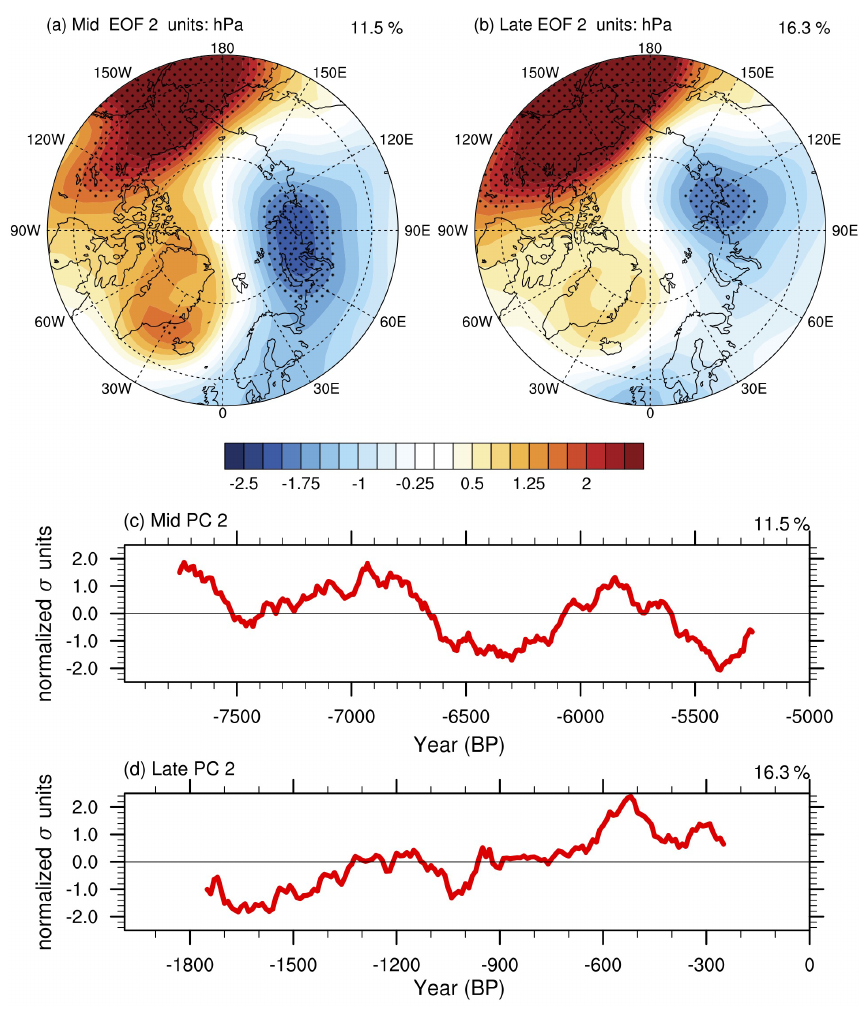
Figure 6. The second EOF (EOF2) pattern of sea level pressure in NNU-Hol All forcing simulations during 5–8ka (a) and 0–2ka (b) . The second principal component time series of the EOF during 5–8ka (c) and 0–2ka (d) after 50 years (smoothed). Areas that are dotted are significant at the 90% confidence